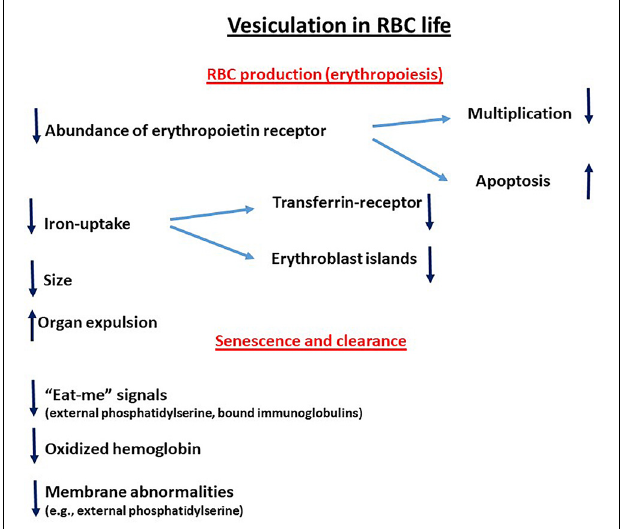
FIGURE 1 | Vesiculation in RBC life. ↑ Upregulation; ↓